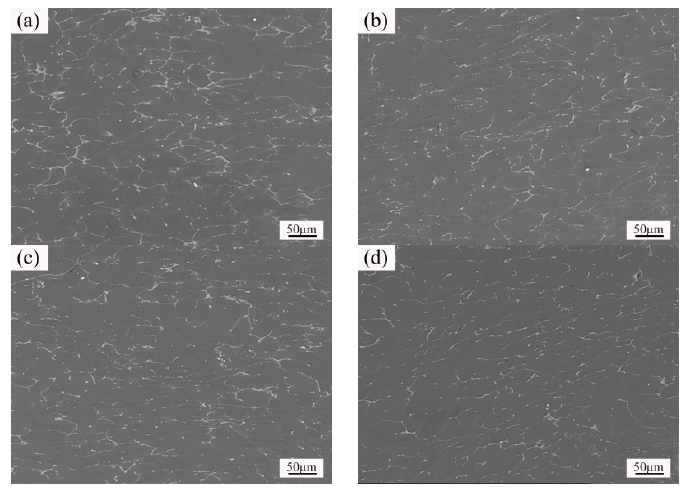
Figure 12. The SEM microstructure of the isothermal forging parts at different temperatures of: ( a ) 320 °C, ( b ) 340 °C, ( c ) 360 °C, ( d ) 380 °C.